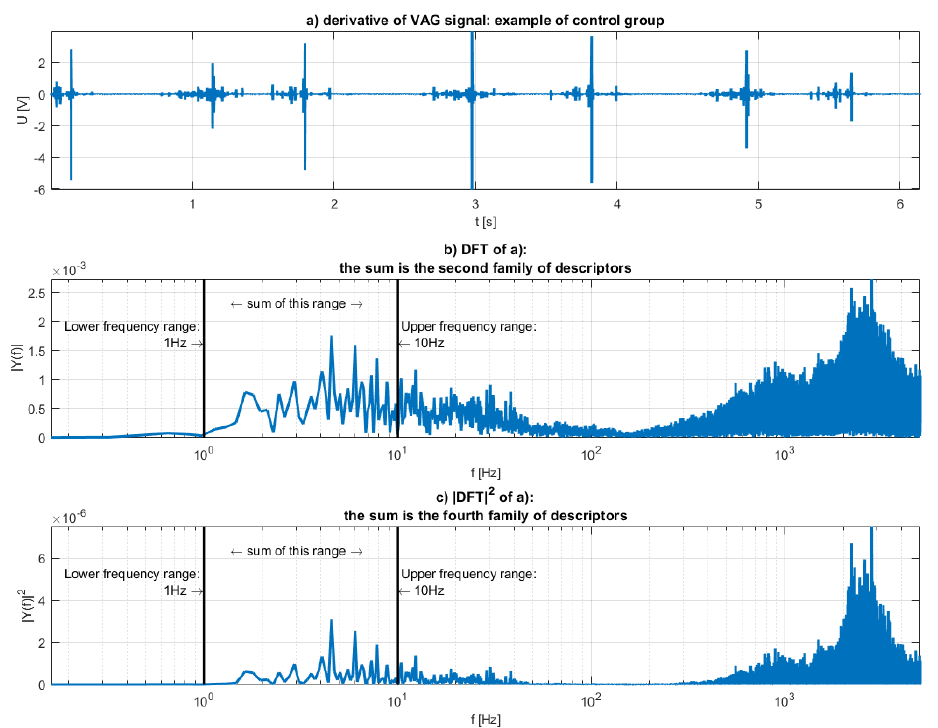
Figure 3. Visualization of the first and the third family of features: ( a ) the analyzed VAG signal, ( b ) the spectrum of the ( a ), ( c ) the squared spectrum.